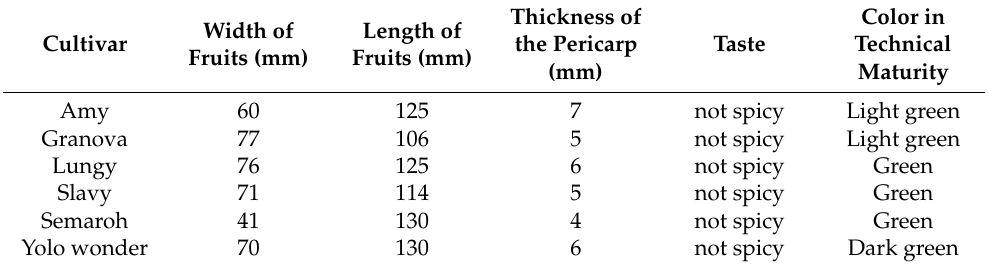
Table 1. Properties of pepper